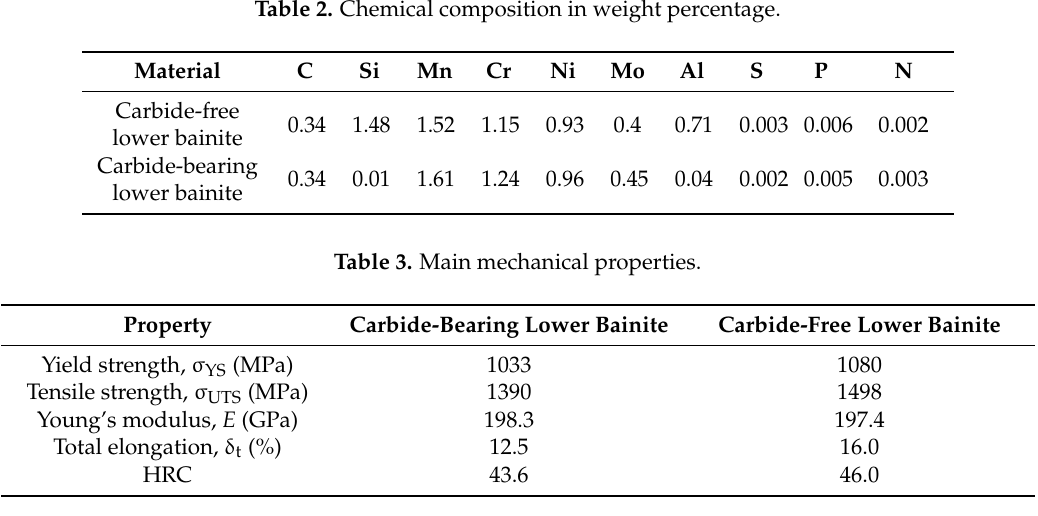
Table 2. Chemical composition in weight percentage.